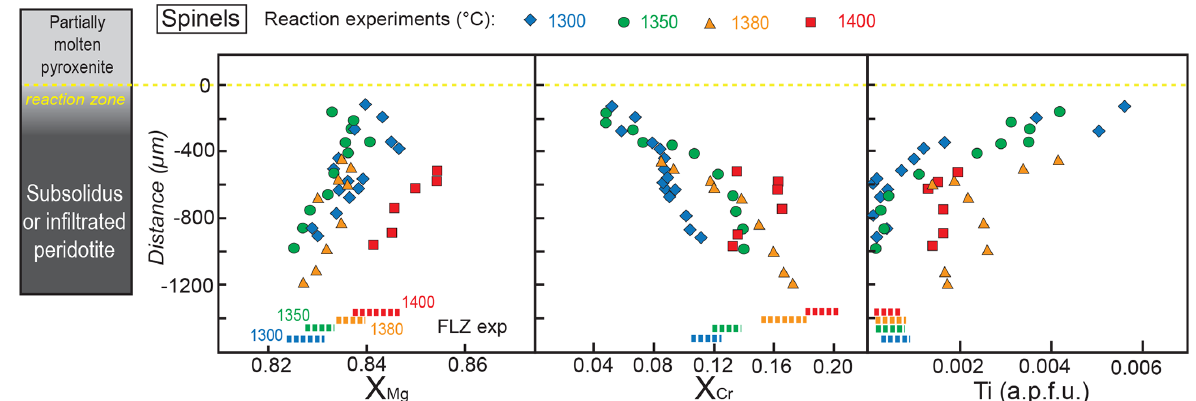
Figure 8. Profiles of X Mg [ X Mg = Mg /( Mg + Fe tot ) ] , X Cr [ X Cr = Cr /( Cr + Al ) ] , and Ti content (a.p.f.u.) in spinel along the peridotite layer after reaction experiments at 2GPa. Distance = 0µm marks the interface between the partially molten pyroxenite and the orthopyroxene-rich reaction layer. Dashed lines at the bottom represent the compositional range measured in spinel from FLZ experiments at 2GPa and 1300– 1400 ◦ C. The inset on the left schematically illustrates the run products with partially molten pyroxenite, reaction zone and peridotite layer from top to bottom of the charges,